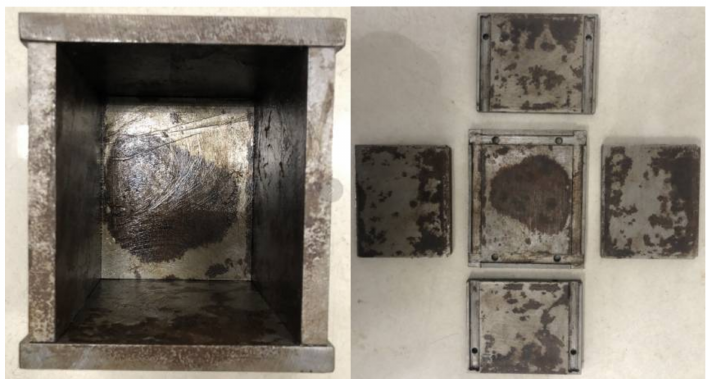
Figure 12. Mold for making the NGH reservoir samples.